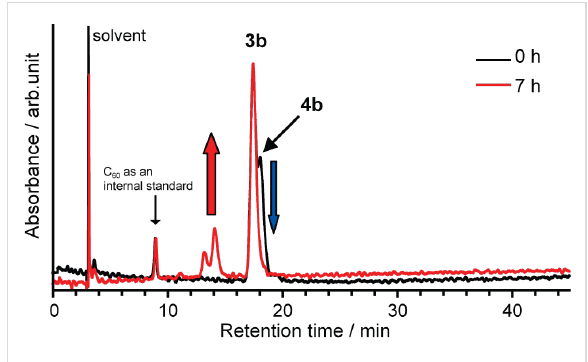
Figure 7: HPLC profiles of the reaction mixture of 3b and 4b , (black) before and (red) after heating in refluxing toluene. Conditions: column, Buckyprep (Ø 4.6 mm × 250 mm); eluent, toluene; flow rate, 1.0 mL/min; wavelength, 330 nm; rt.